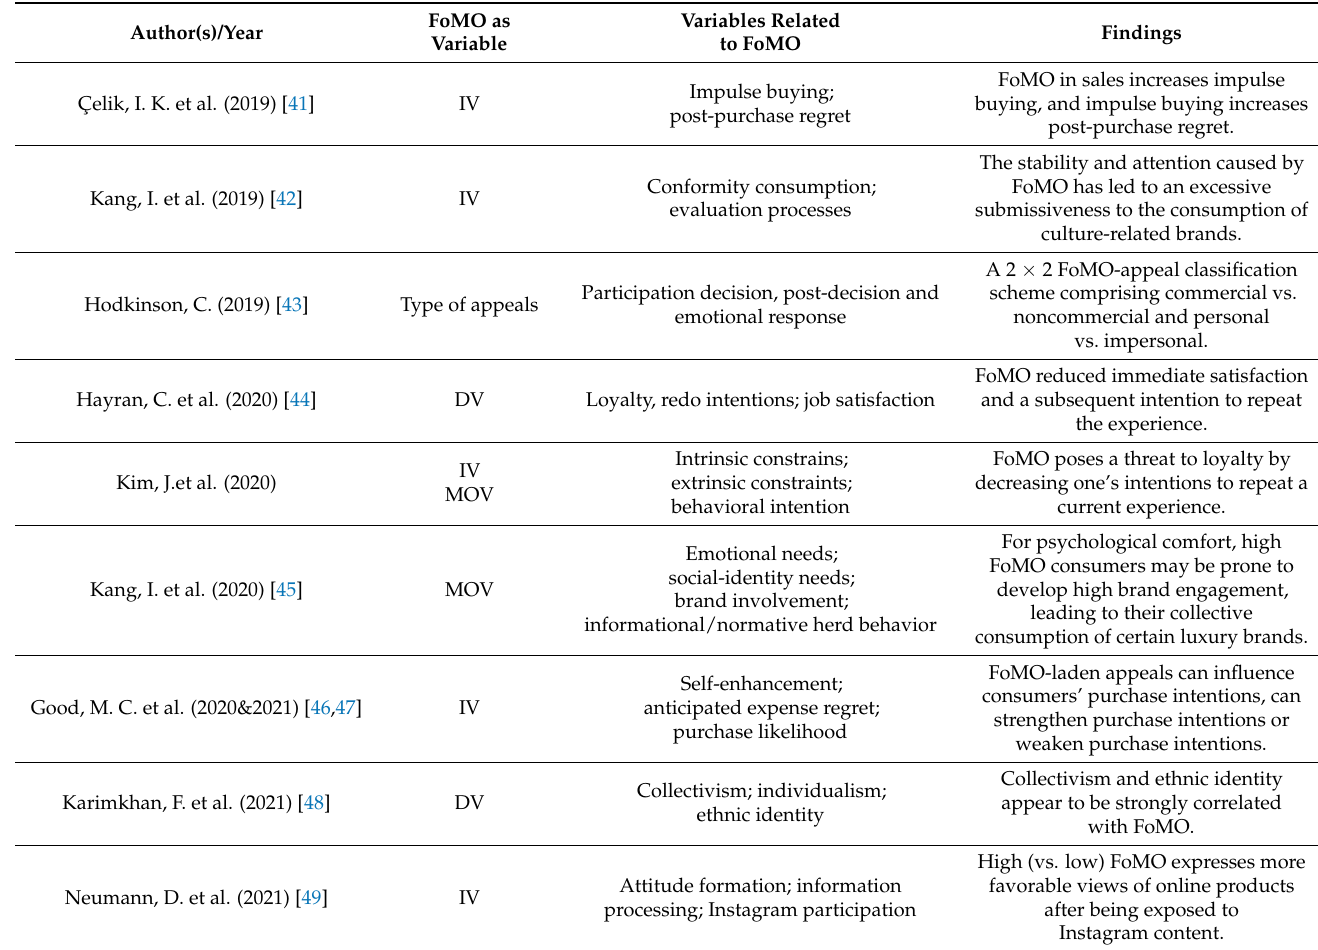
Table 2. Representative literature of FoMO-related marketing